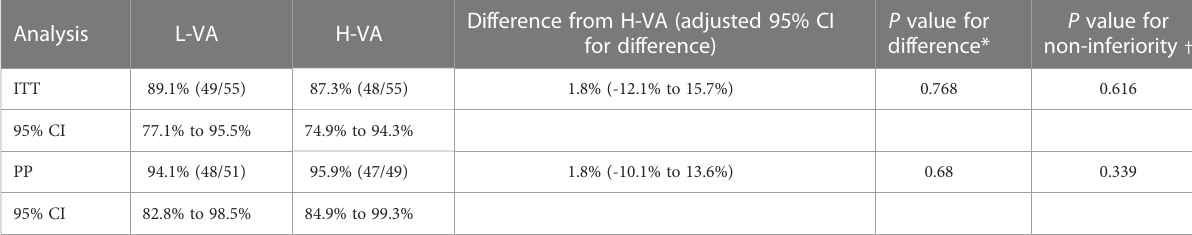
TABLE 2 Eradication rate of each treatment